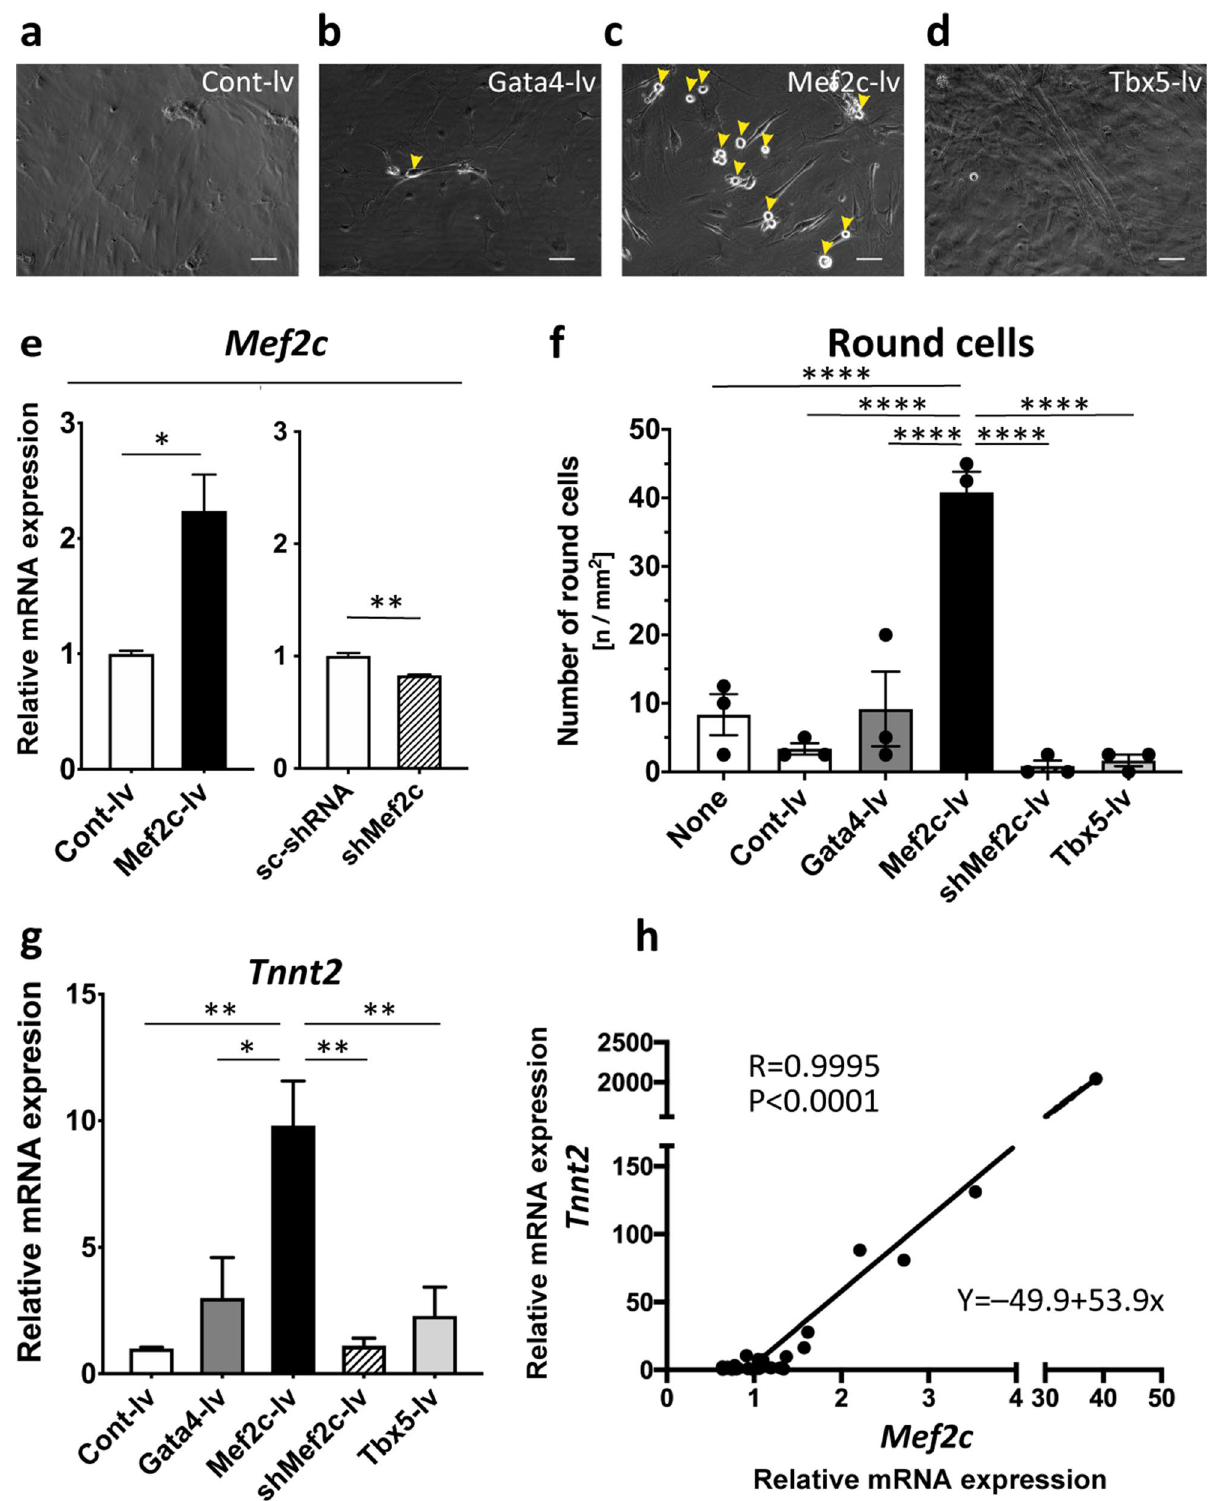
Figure 7. Overexpression of SVF with Mef2c augments the number of round cells and their transdifferentiation into CMs. ( a – d ) Phase-contrast images of SVF on day 28 after transfection on day 5 ( a , control; b , Gata4; c , Mef2c; d , Tbx5). Arrowheads indicate round cells; lv, lentivirus vector. ( e ) mRNA level of Mef2c, determined by qRT-PCR, on day 28 in SVFs transfected with the control vector and Mef2c-lv (left), or scrambled shRNA and shMef2c-lv (right), on day 5, respectively. shRNA, short hairpin RNA; shMef2c, shRNA targeting Mef2c. ( f ) Number of round cells on day 14 after introducing SVF with none (none) or the control, Gata4, Mef2c, shMef2c, or Tbx5 lentivirus vector. ( g ) mRNA level of cardiac troponin T by qRT-PCR on day 28 in SVF transfected with the control, Gata4, Mef2c, shMef2c, or Tbx5. ( h ) Relationship between the mRNA levels of Mef2c and cardiac troponin T in the SVF transduced with Mef2c. R, Pearson’s product-moment correlation coefficient. The linear interpolation formula is displayed. Scale bar = 100 µm. * p < 0.05; ** p < 0.01; **** p < 0.0001 by ANOVA and Tukey’s post hoc